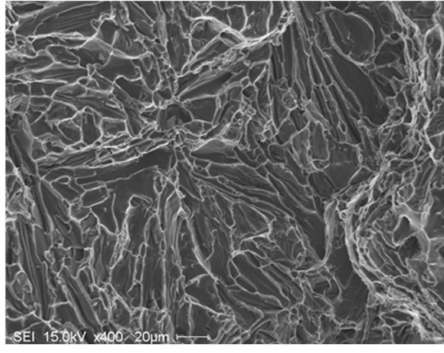
Figure 12. Fracture surface of the A1 alloy in the as cast condition, DAS ~ 25 µ